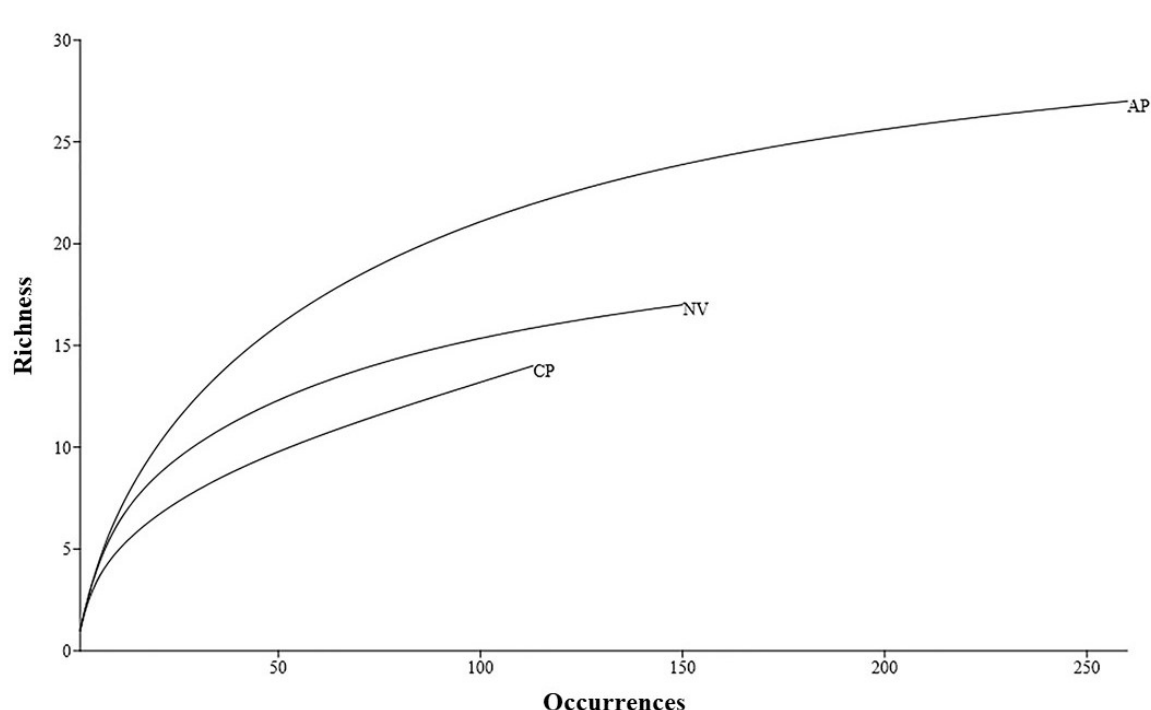
Figure 2. Comparison by the rarefaction method, based on the number of occurrences and of the accumulated richness of ant assemblages from three environments in Colônia São Manoel, Pelotas, RS, Brasil